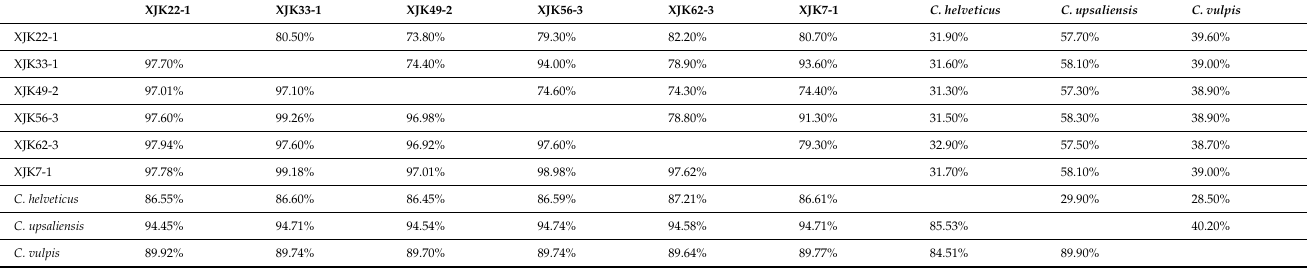
Table 5. ANI (lower diagonal) and dDDH (upper diagonal) among the novel Campylobacter strains and other Campylobacter